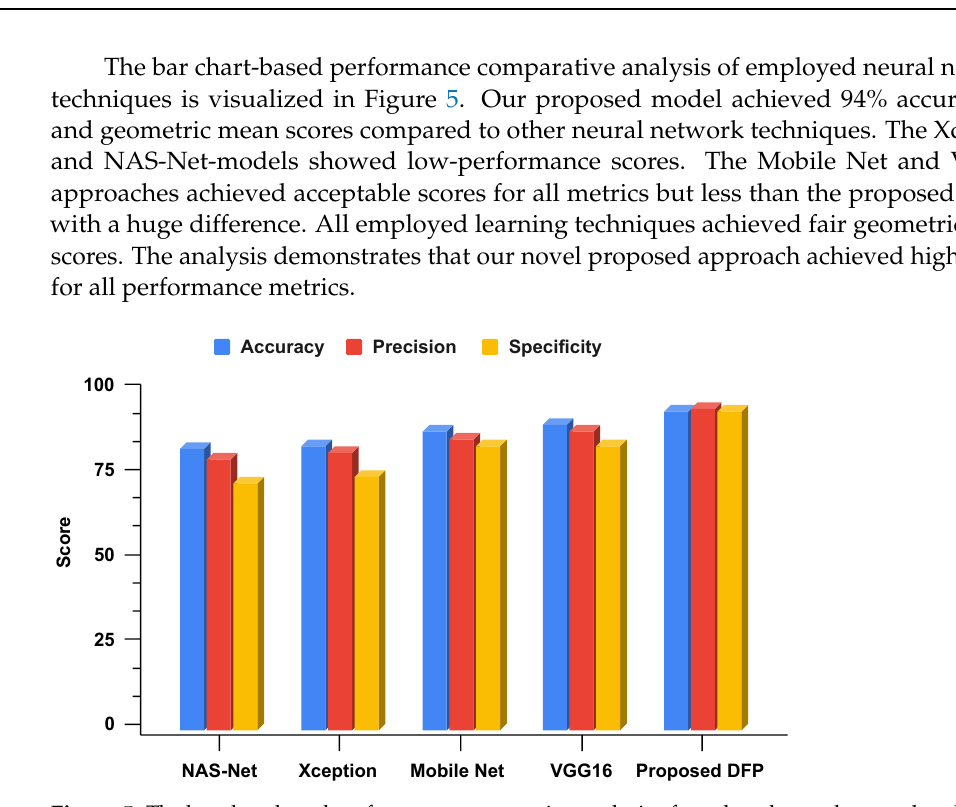
Figure 5. The bar chart-based performance comparative analysis of employed neural network